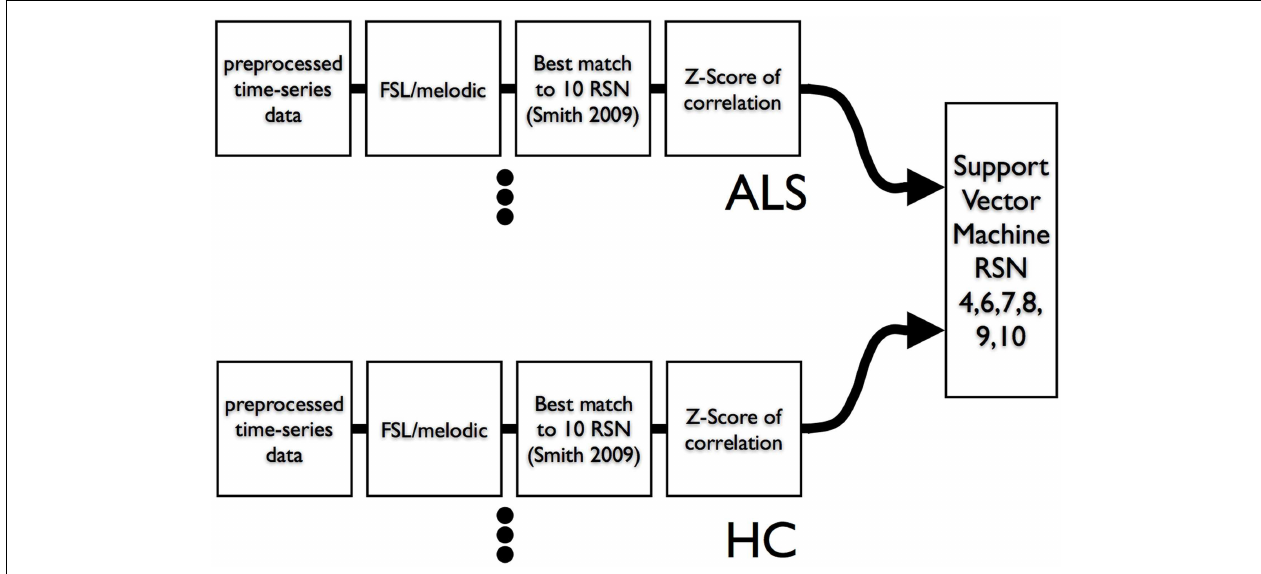
FIGURE 3 | Data flow of resting-state times series into ICA and then into SVM . A leave-one-out-cross-validation was utilized to assess SVM classification